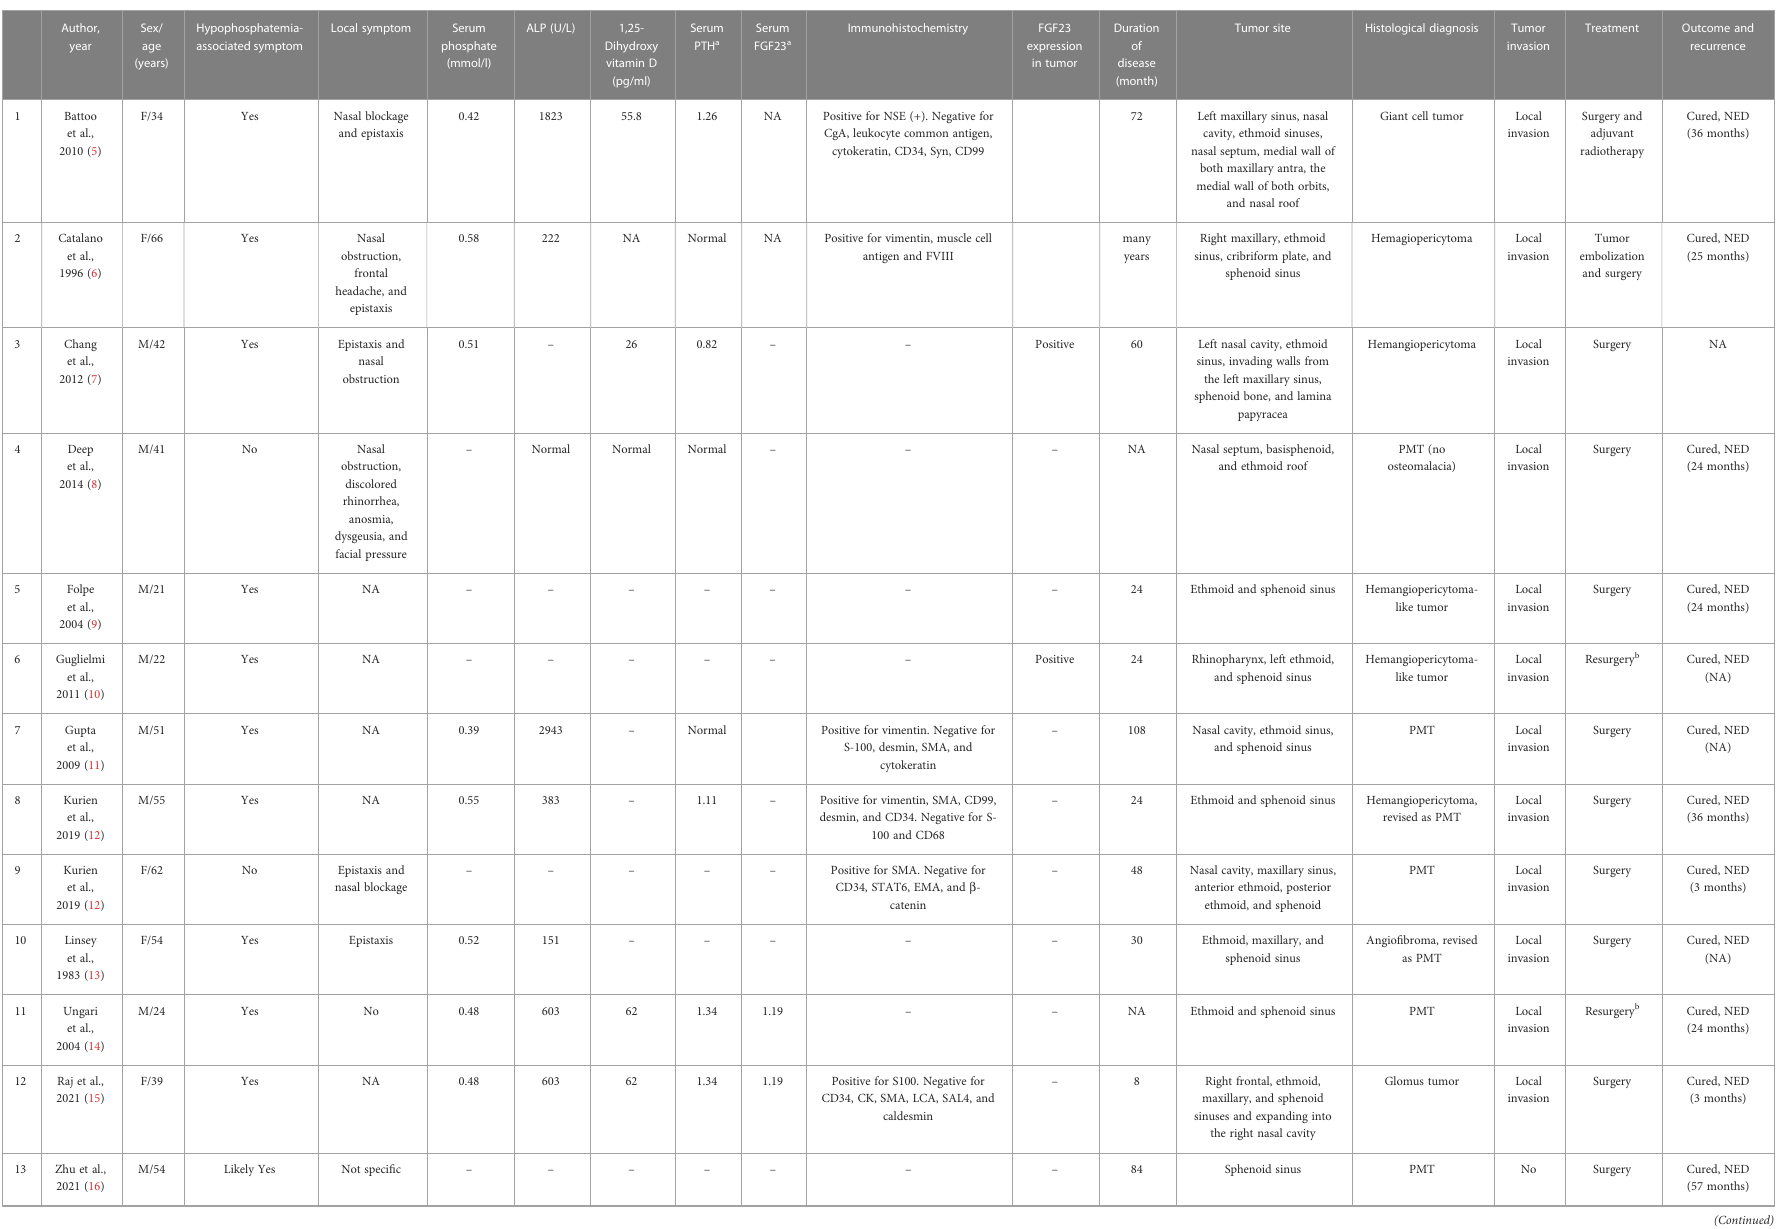
TABLE 1 Clinical features, diagnosis, and outcomes of tumor-induced osteomalacias (TIOs) in the sphenoid sinus. Author,